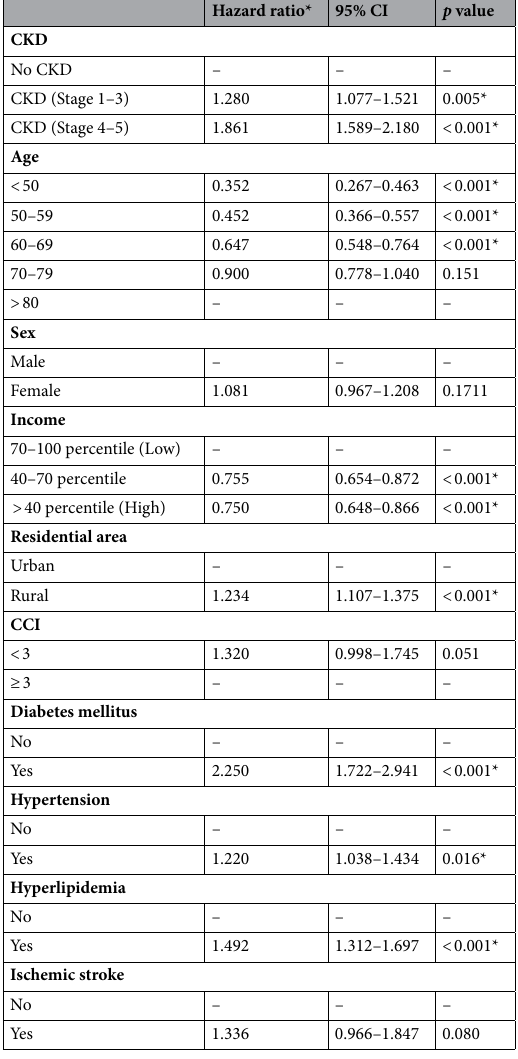
Table 3. Hazard ratios for open-angle glaucoma in multivariable Cox regression analysis according to severity of chronic kidney disease. * p < 0.05. OAG , open-angle glaucoma; CKD , chronic kidney disease; CCI , Charlson comorbidity index. *Adjusted for all variables shown in the table.